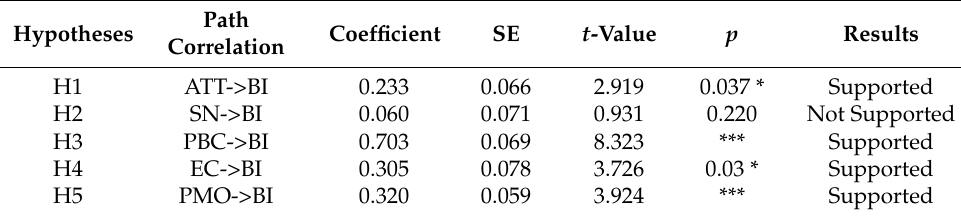
Figure 2. Hypothesis testing results of E-TPB model. Table 8. Results of the hypothesis test.